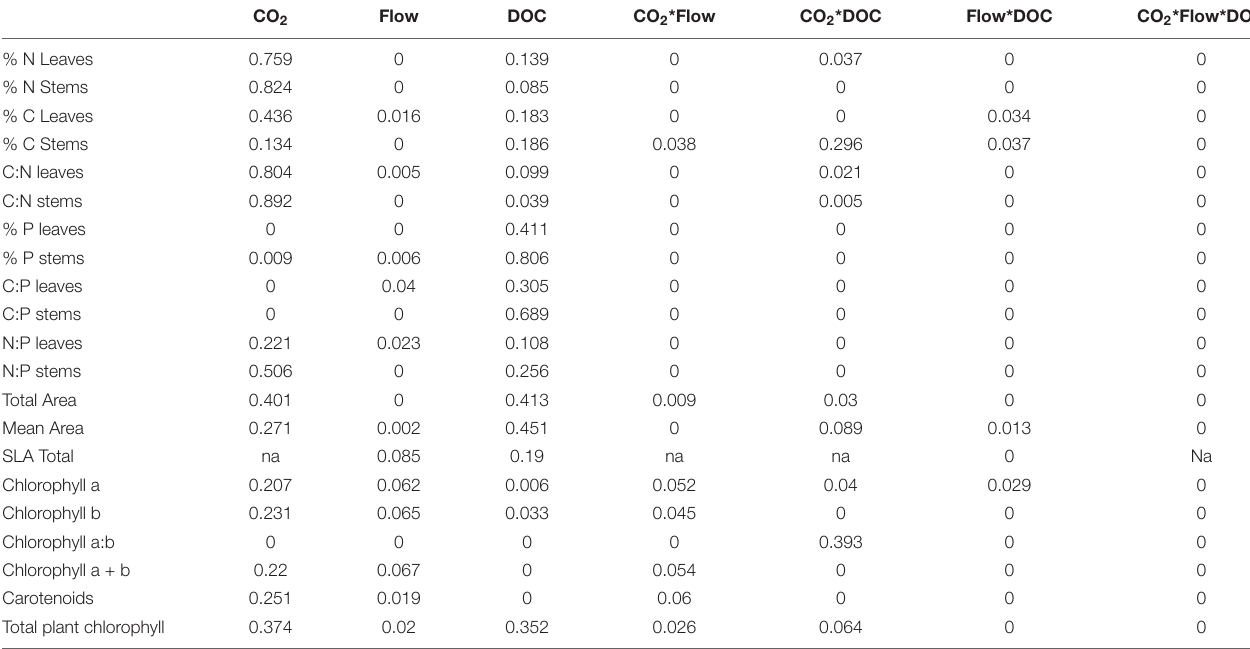
TABLE 4 | Omega squared values for the morphological parameters, chlorophyll and nutrient stoichiometry parameters ( n =